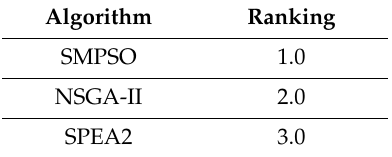
Table 3. Average ranking of the algorithms considering the I SP metric. Friedman statistic considering